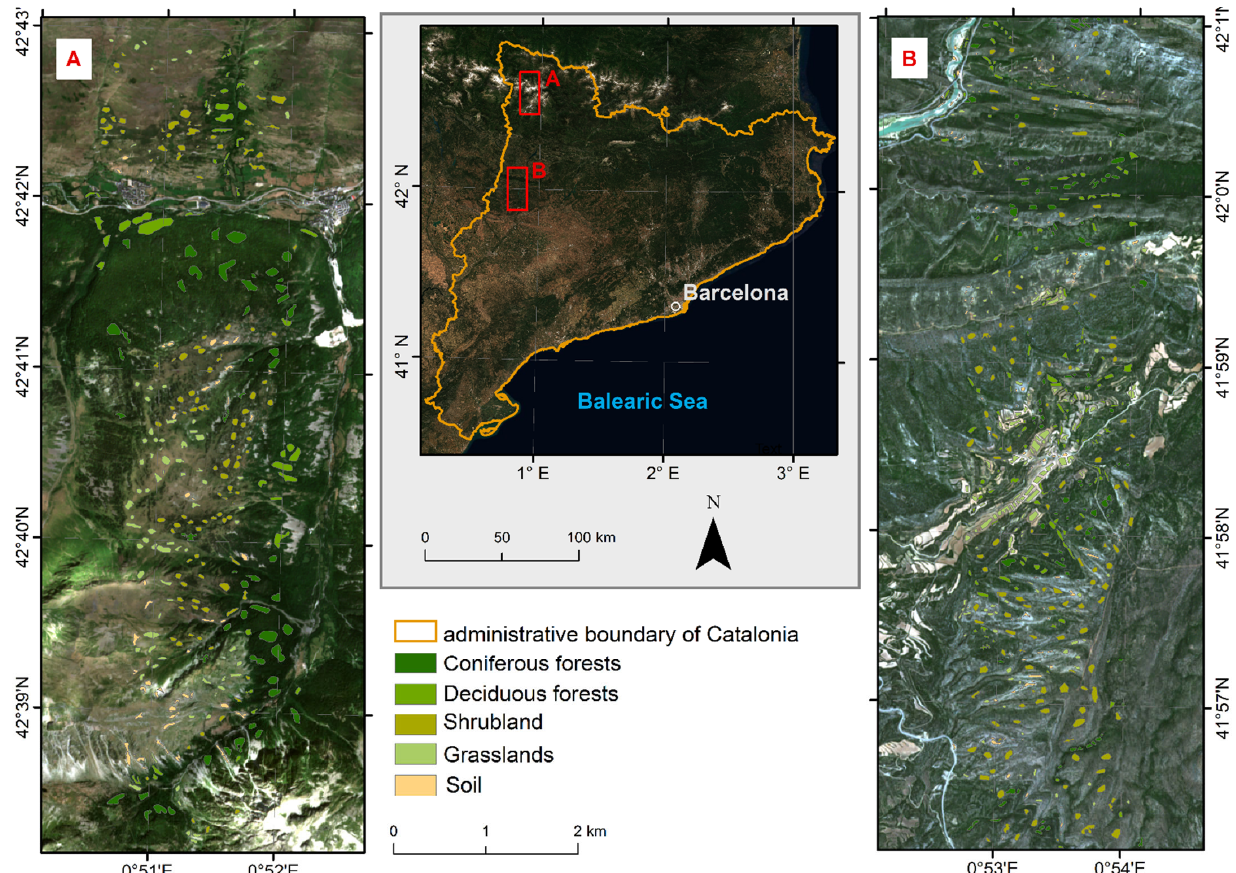
Figure 1. Research area A (mountain Pyrenean region: the Valarties valley–an Atlantic vegetation type) and B (the pre ‐ Pyrenees–Montsec region: a Mediterranean vegetation), in the background Sentinel-2 RGB 432 composition.